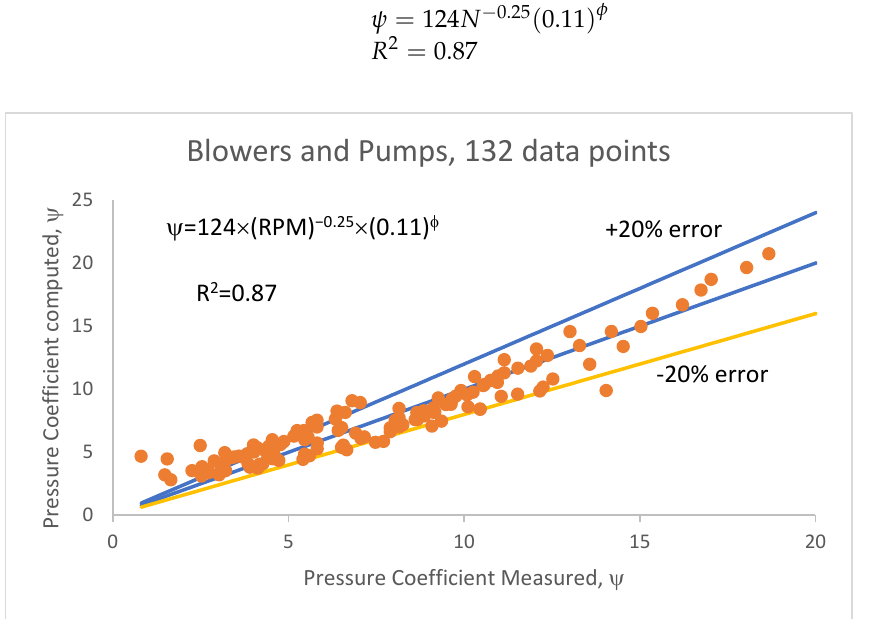
Figure 4. Computed vs. measured pressure coefficient for one ‐ side vane impeller blowers and pumps.